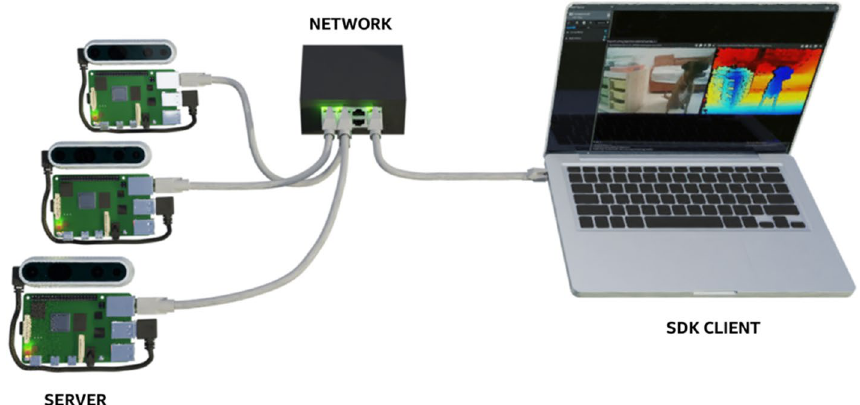
Fig. 1 Network configuration for handling several depth